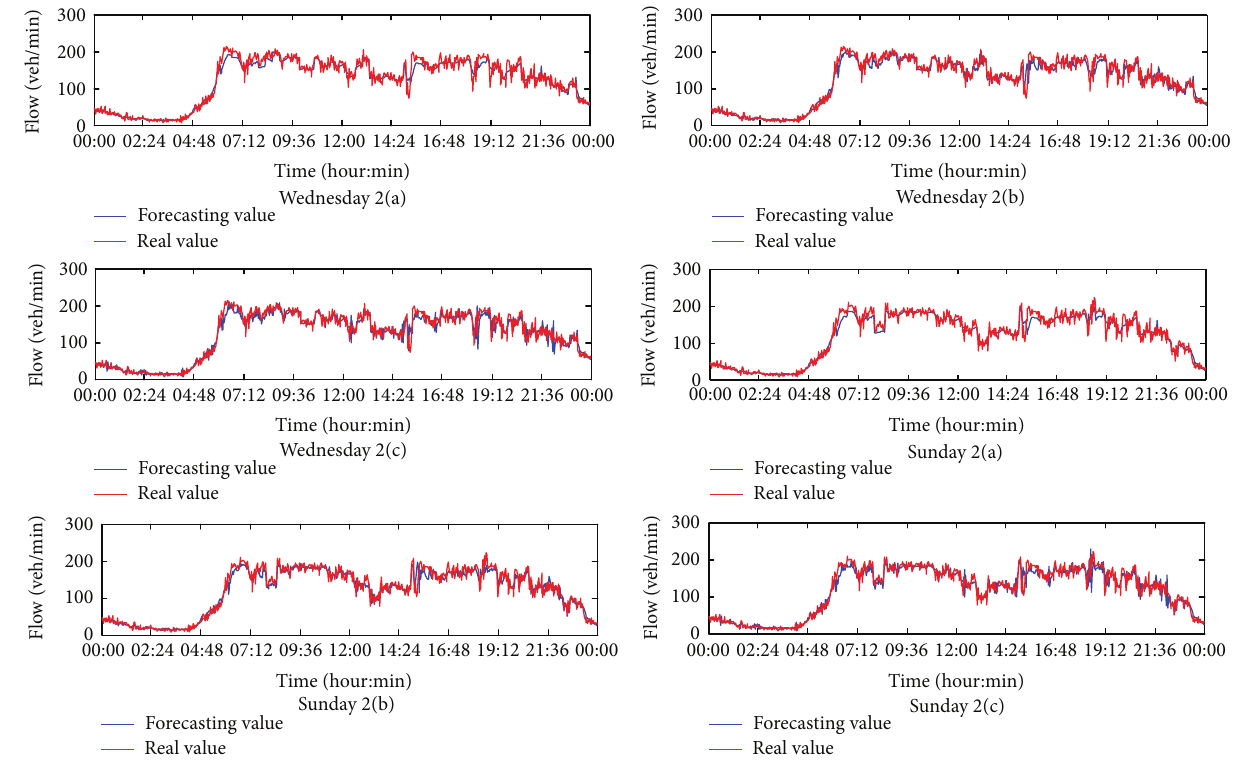
Figure 4: the result of forecasting the traffic